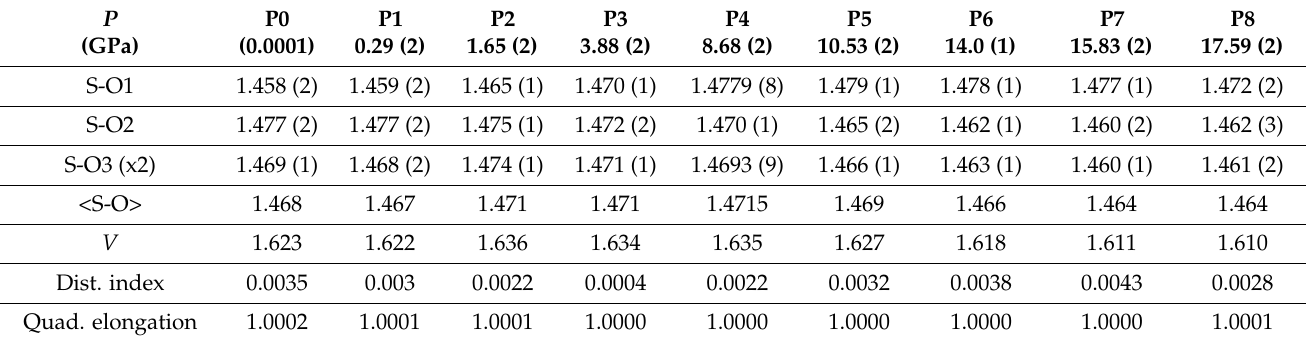
Figure 3. F-f plot. Eulerian finite ( f E ) strain versus normalized stress ( F E ) with the weighted linear regression through the volume cell data points (graph with black dots), through the a lattice parameters (graph with red dots), through the b lattice parameters (graph with blue dots) and trough c lattice parameters (graph with green dots). Table 3. Bond distances (Å), volume (Å 3 ), and distortion parameters of the SO 4 polyhedron at different